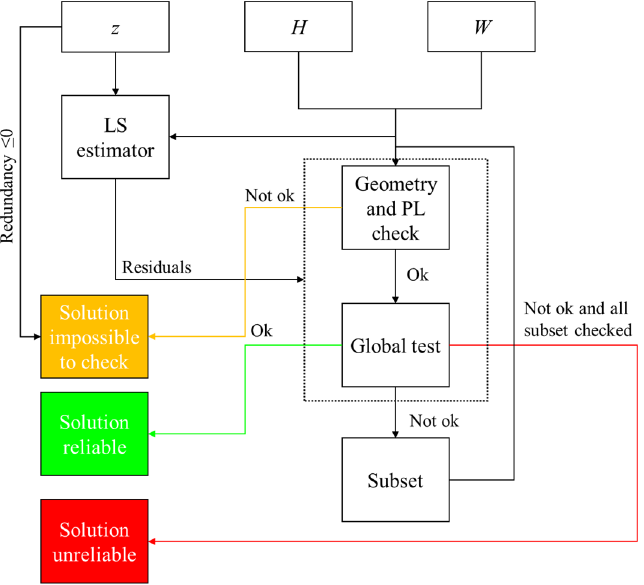
Figure 3. RAIM Subset algorithm.